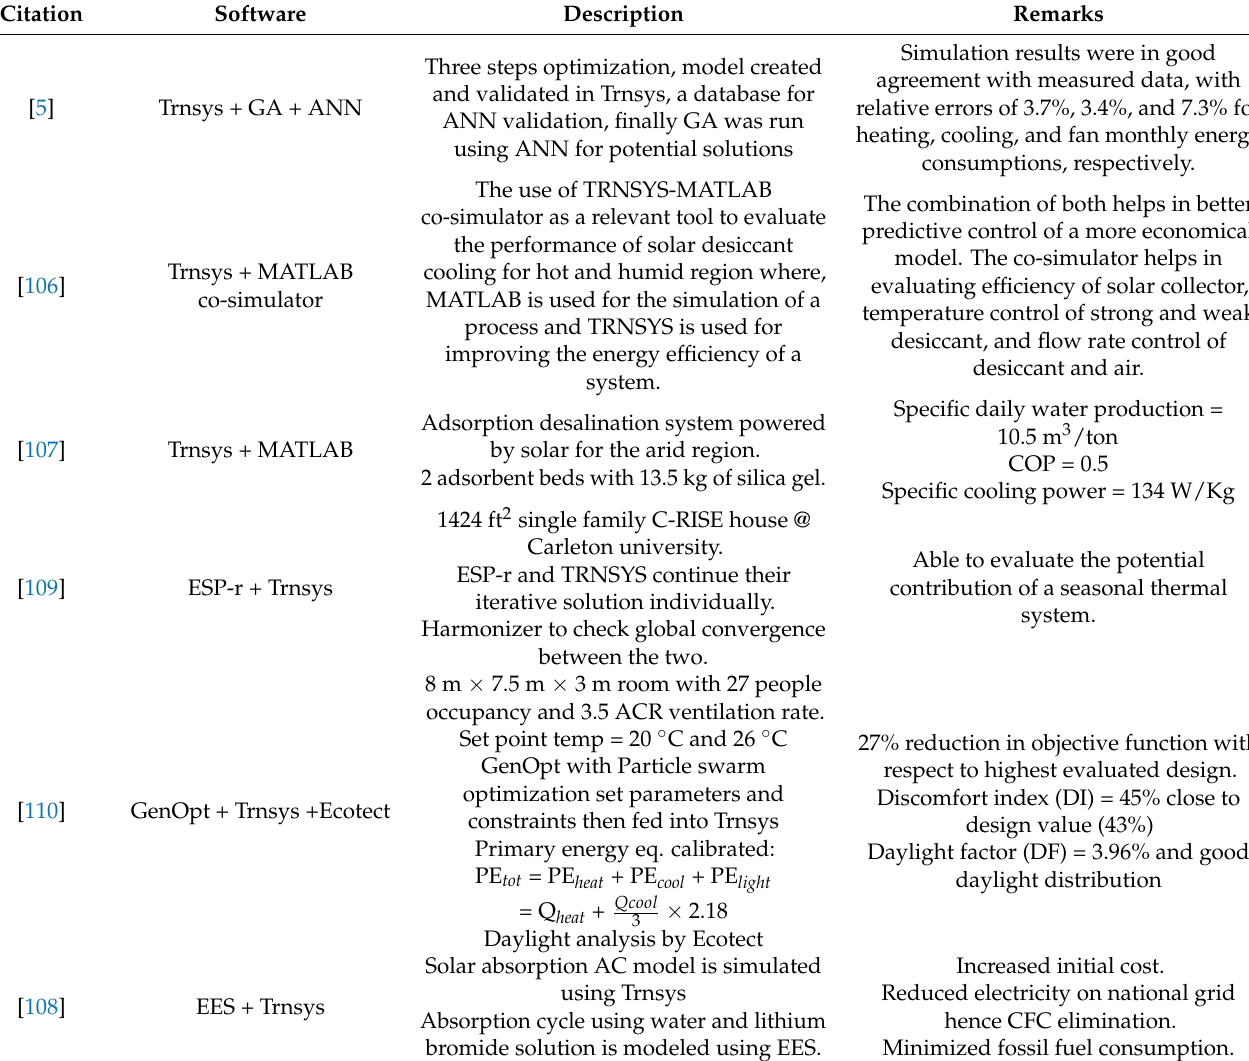
Table 5. Software coupling for integrated